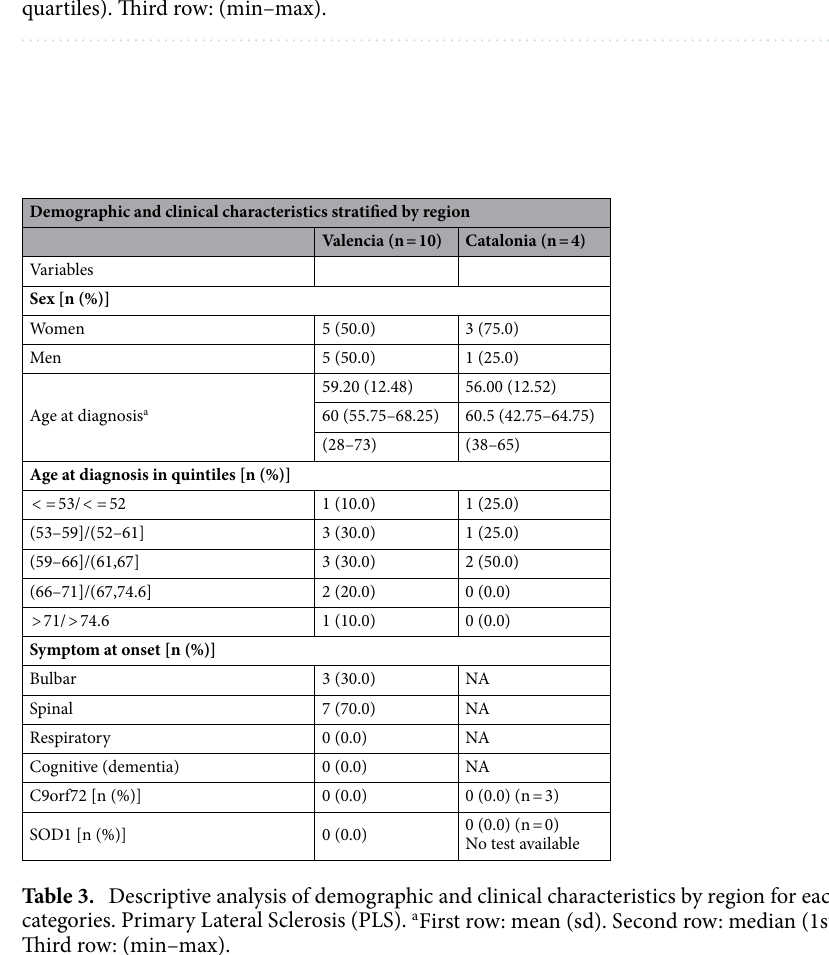
Table 2. Descriptive analysis of demographic and clinical characteristics by region for each of the diagnostic categories. Progressive Muscular Atrophy (PMA) a First row: mean (sd). Second row: median (1st-3rd quartiles). Third row: (min–max).